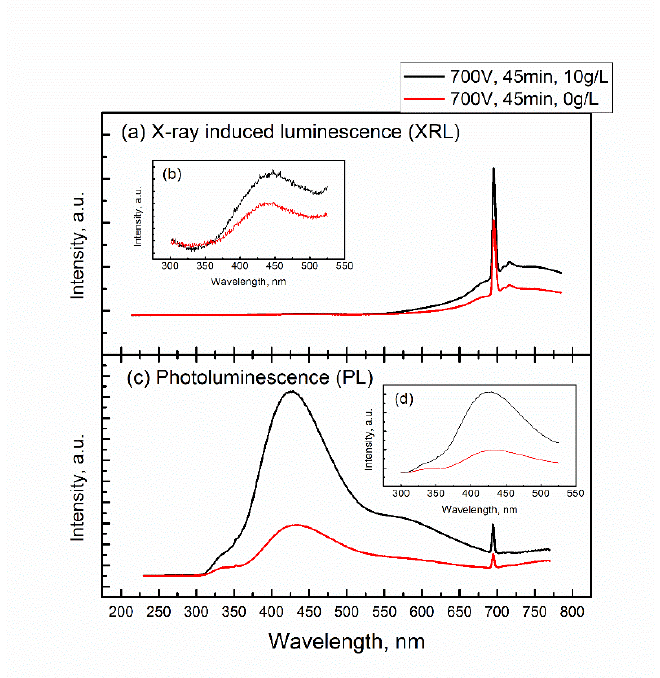
Figure 4. ( a ) XRL spectra of samples with concentrations of 10 g · L − 1 and 0 g · L − 1 citric acid used in electrolyte during PEO process, ( b ) intrinsic defect range 300 – 550 nm; ( c ) PL spectra of samples with concentrations of 10 g · L − 1 and 0 g · L − 1 citric acid used in electrolyte during PEO process, ( d ) intrinsic defect range 300 – 550 nm.